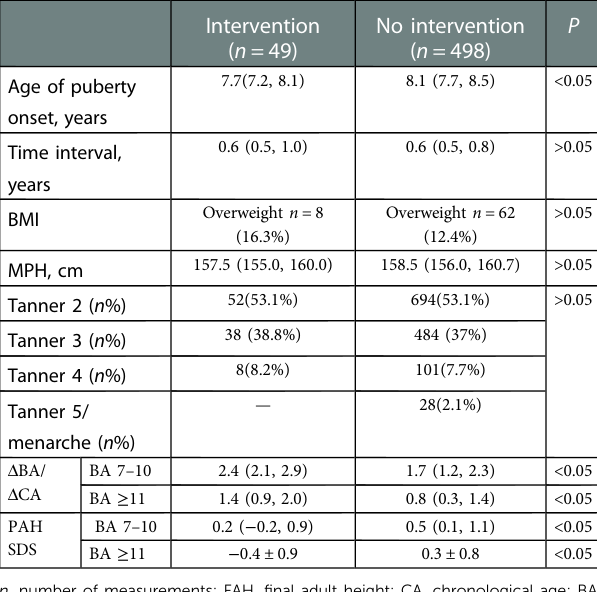
FIGURE 2 Height-for-CA/BA percentile curves and Δ HtSDS-for-CA/BA charts for girls with EP. CA, chronological age; BA, bone age; Δ HtSDS, changes in the height standard deviation score; EP, early-onset